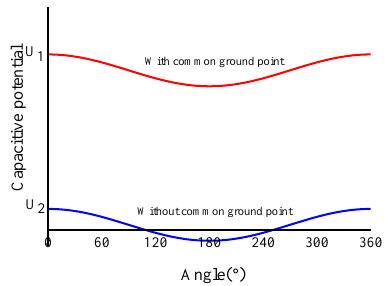
Figure 5. Capacitive potential of inductosyn.